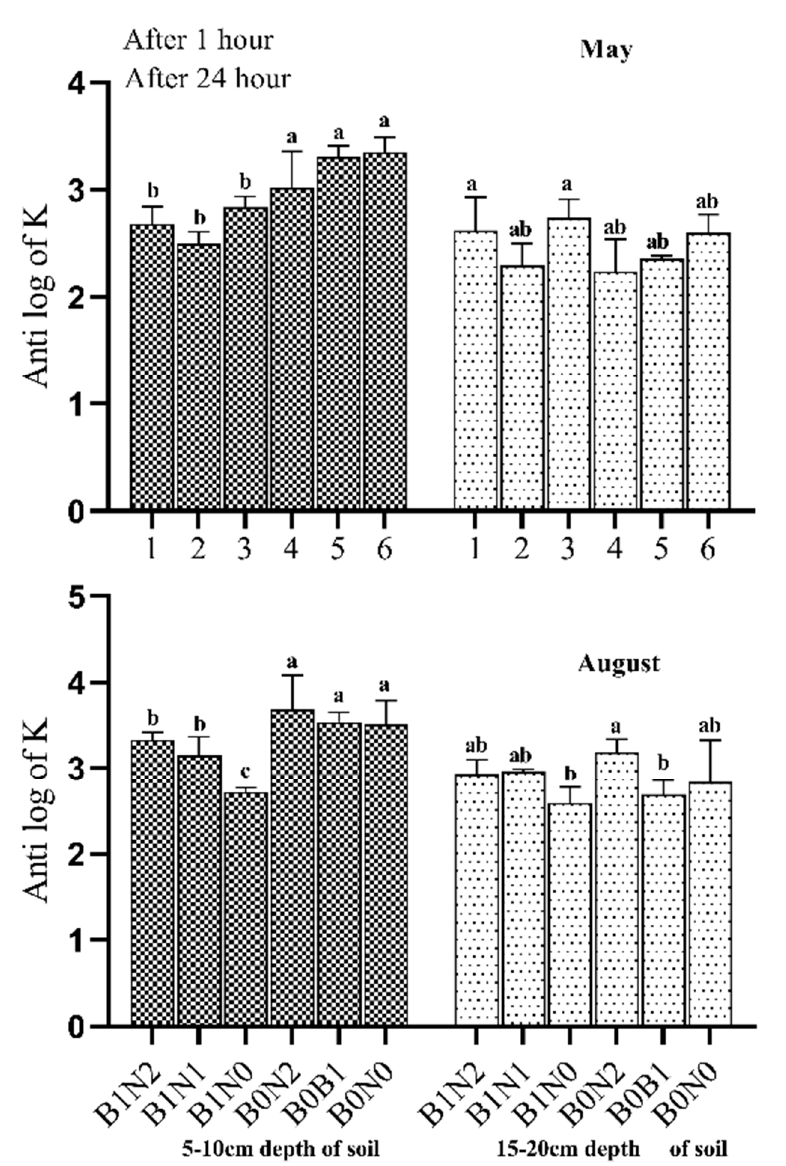
Figure 5. Effect of different treatments on soil hydraulic conductivity. B0N0 (without biochar or N fertilization); B0N1 (without biochar and with 160 kg · ha − 1 N); B0N2 (without biochar and with 120 kg · ha − 1 N); B1N0 (biochar 25 t · ha − 1 only); B1N1 (biochar 25 t · ha − 1 and 160 kg · ha − 1 N); and B1N2 (biochar 25 t · ha − 1 and 120 kg · ha − 1 N) at two different depths (5–10 cm and 15–20 cm) and times (May and August). The letters a, b, c indicate statistically significant difference at p < 0.05.